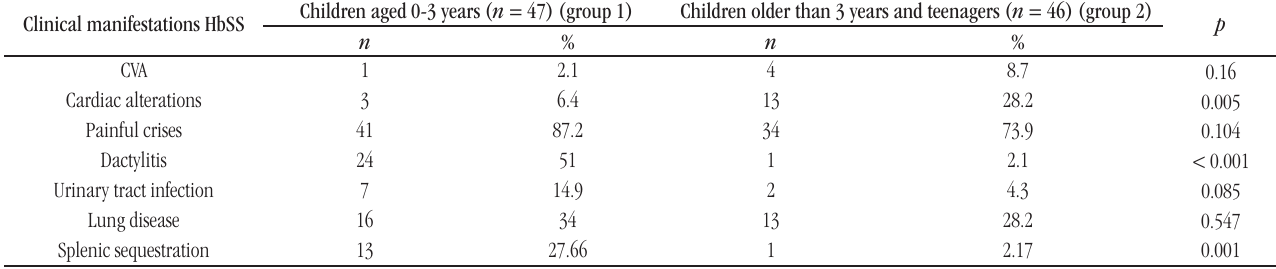
taBLE 2 − Clinical manifestations according to age group